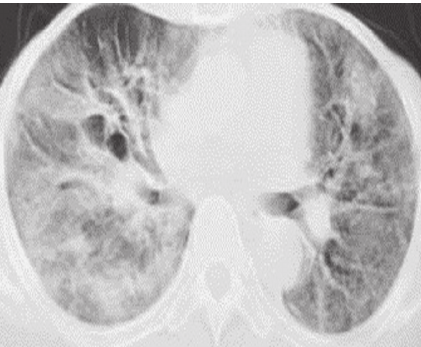
Figure 1: Section of the HRCT chest done on presentation showing bilateral ground glass opacities and a degree of bronchiectasis.